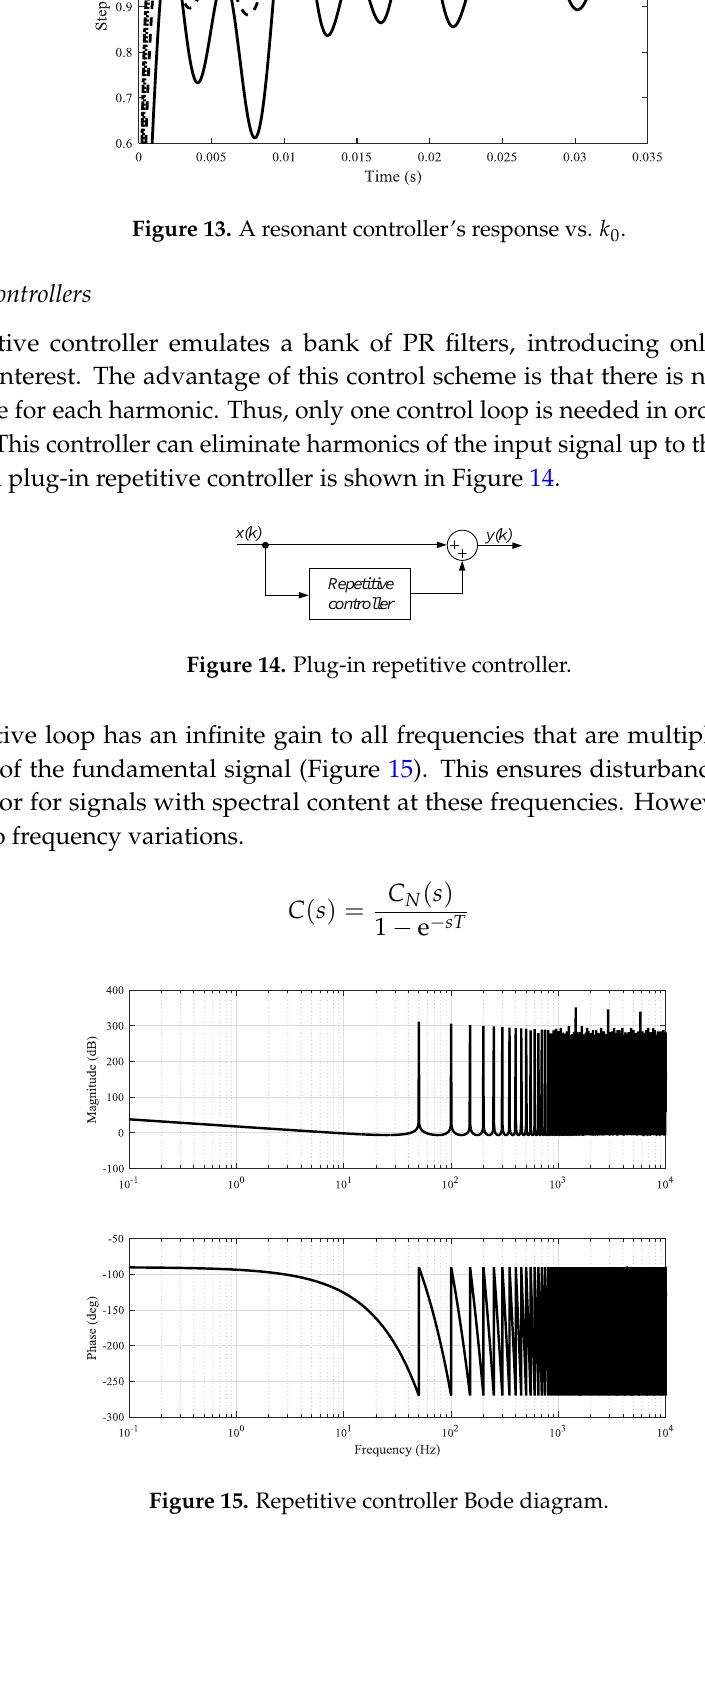
Figure 15. Repetitive controller Bode diagram.